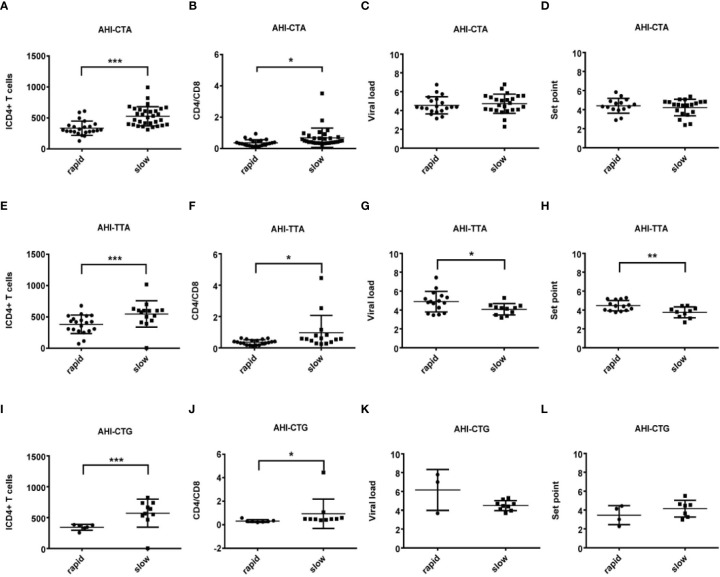
Relationship between clinical parameters and AHI patients with rapid/slow progression who carry different haplotypes (CTA/TTA/CTG). (A–H) There are four clinical parameters including, ICD4 (initial CD4 T cells) (A, E, I), CD4/CD8 (the ratio of CD4 versus CD8 T cells) (B, F, J), viral load (C, G, K) and set point (D, H, L). The y axis indicates the values of these four respective parameters. The x axis, indicates two patient groups of AHI with rapid and slow progression. The text on the top of each picture represents haplotype CTA/TTA/CTG. Each dot represents an MSM individual, (●) represents individuals of AHI-rapid progress with TLR7 CTA/TTA/CTG haplotype. (■) represents individuals of AHI-slow progress with TLR7 CTA/TTA/CTG haplotype. * indicates P < 0.05; **P < 0.01 and ***P < 0.001.